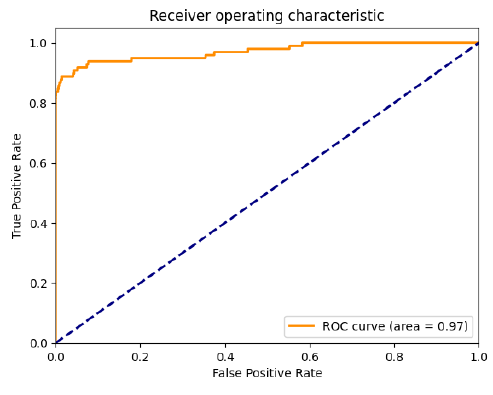
Figure 9. ROC-AUC